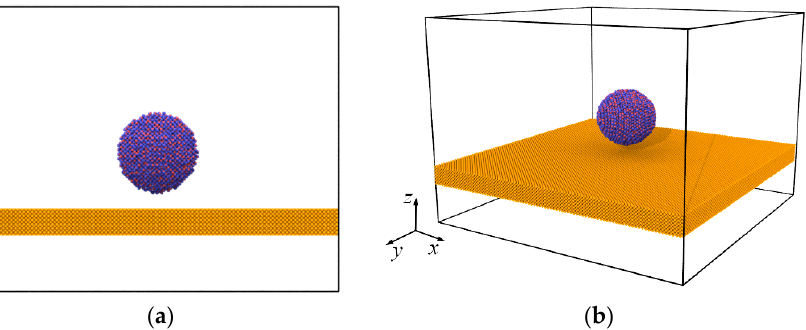
Figure 1. The initial configuration of a water nanodroplet impinging on a moving surface: ( a ) front view; ( b ) perspective view.